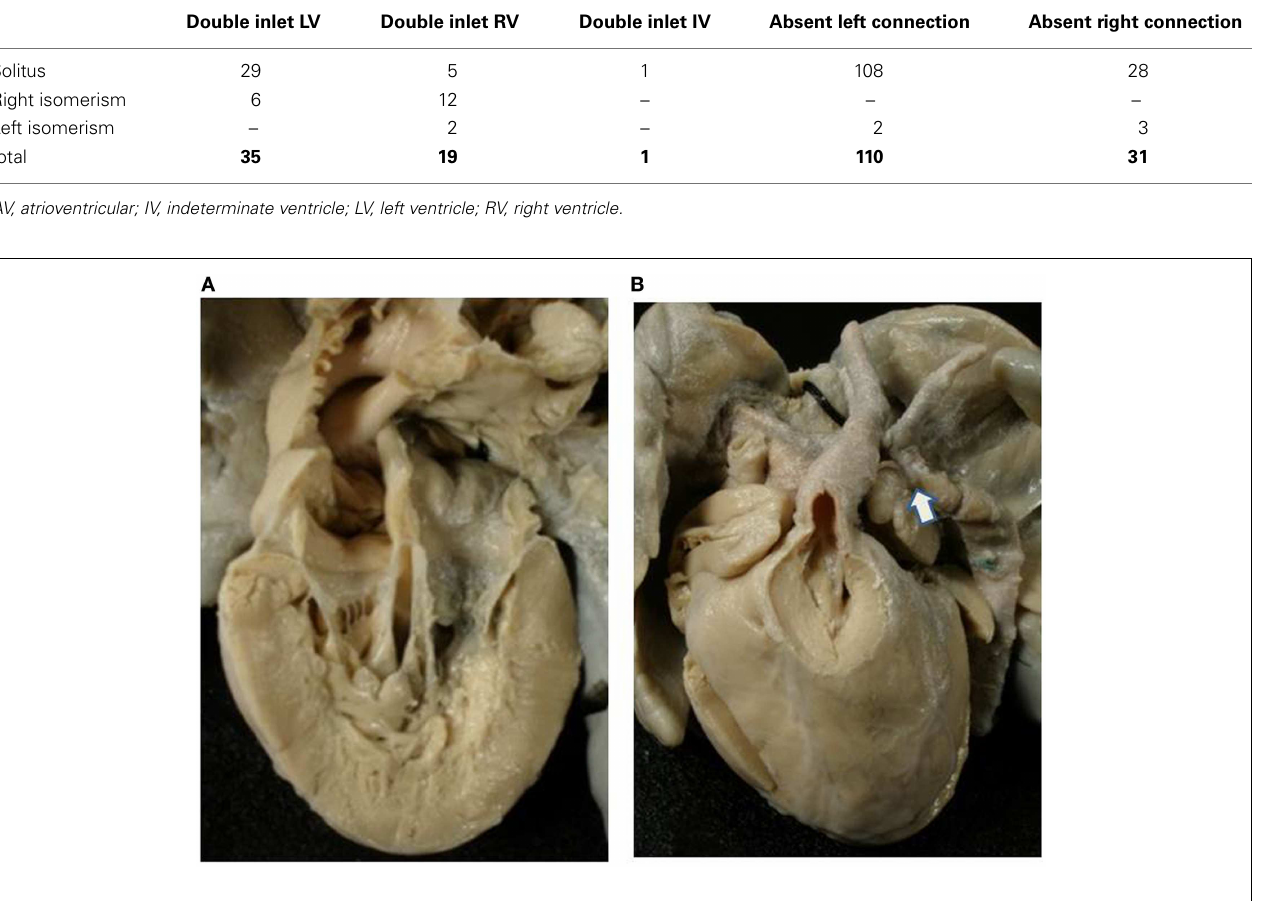
FIGURE 3 | Double inlet left ventricle . (A) Both the AV valves drain into a posterior ventricular chamber of left morphology. (B) External view of the heart: the hypoplastic right ventricle is located in antero-superior position and